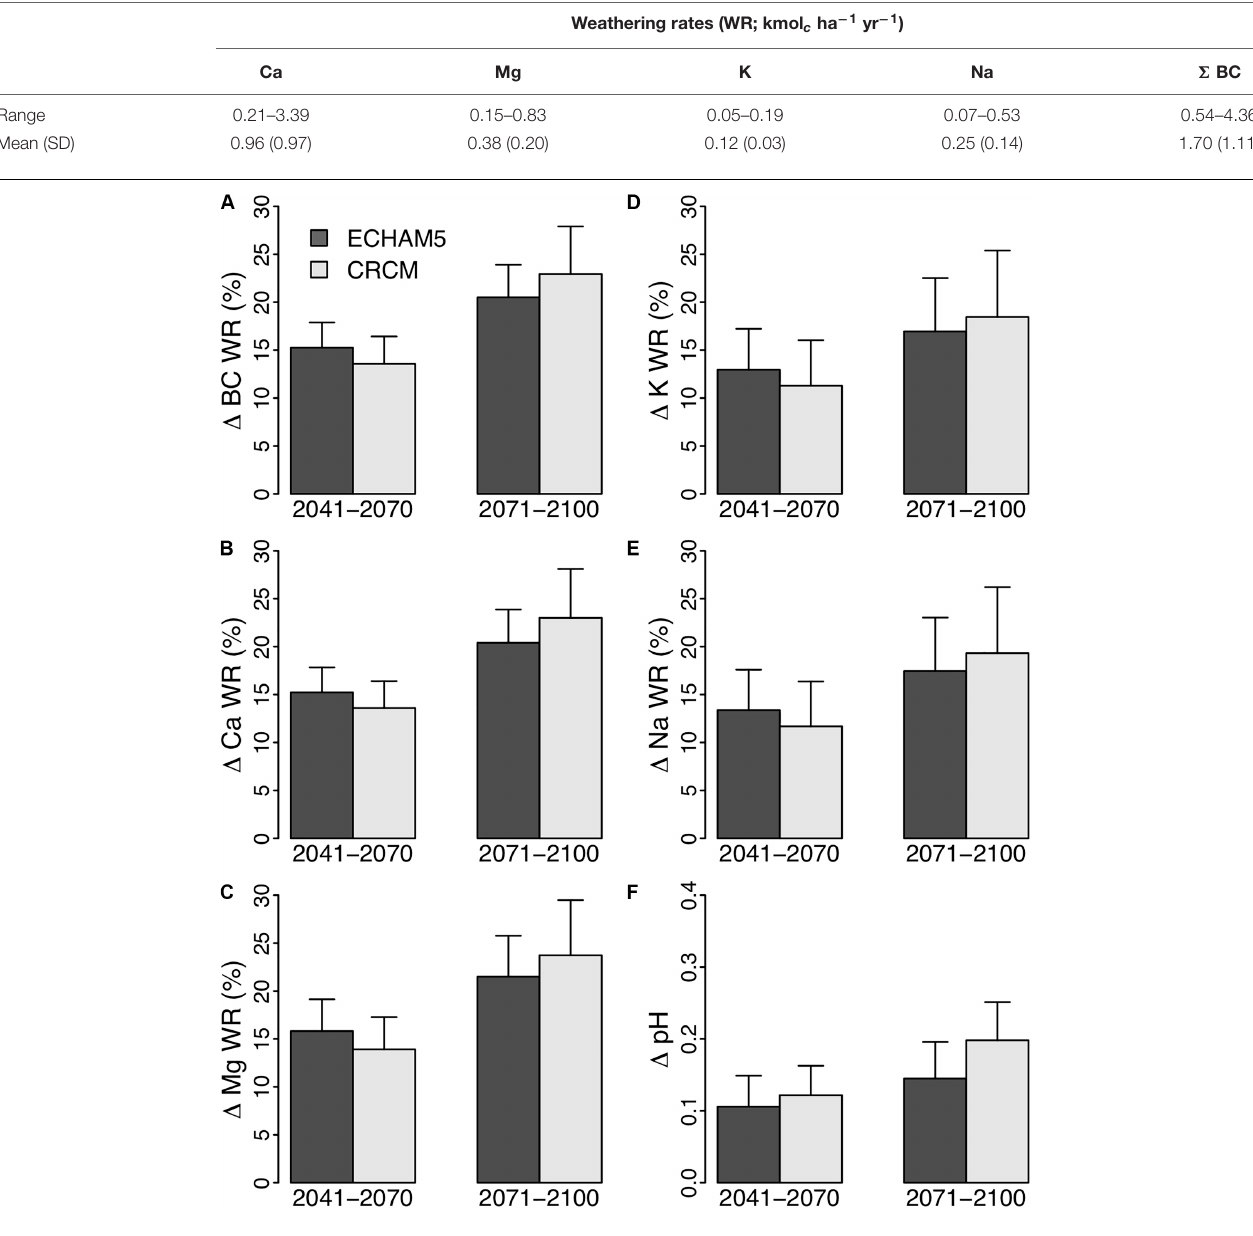
FIGURE 4 | Mean ( ± SD) relative changes in base cation weathering rates ( (cid:49) WR; %) (A–E) and pH (F) for the periods 2041–2070 and 2071–2100 relative to the reference period (1971–2000) with climate projections generated by the ECHAM 5 (global) and CRCM (regional) climate models.